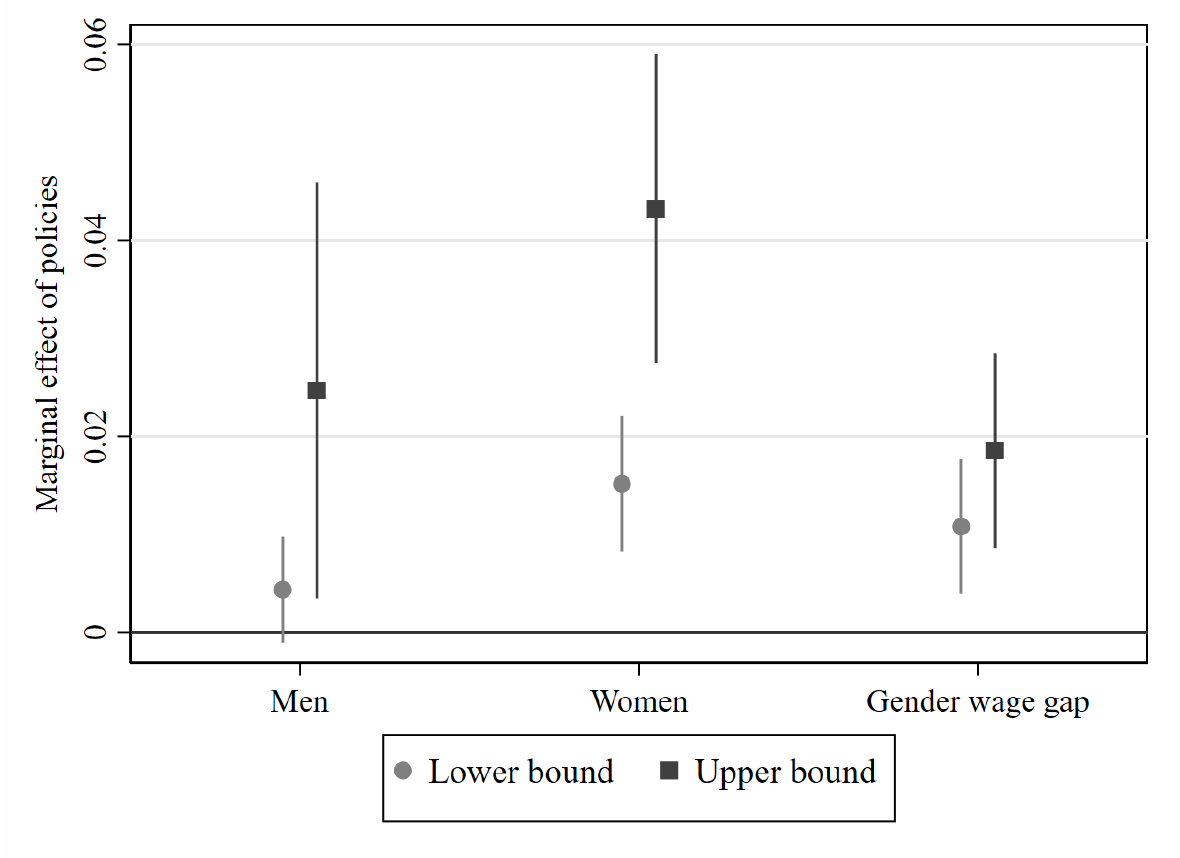
Figure 5: Effect of organizational policies on the wages of men and women and on the gender wage gap. Notes: The marginal effects for men and women can be found in Table A4 in the online supplement and are calculated using the upper and lower bound regression estimates from Table 4. The effect on the intrafirm gender wage gap is the coefficient on Female × Organizational policies from Table 4 for the upper and lower bound specifications. The plot shows the coefficients and the 95 percent confidence intervals calculated using two-tailed t tests. The standard errors are clustered at the firm level. Source: Own calculations using the LIAB QM2